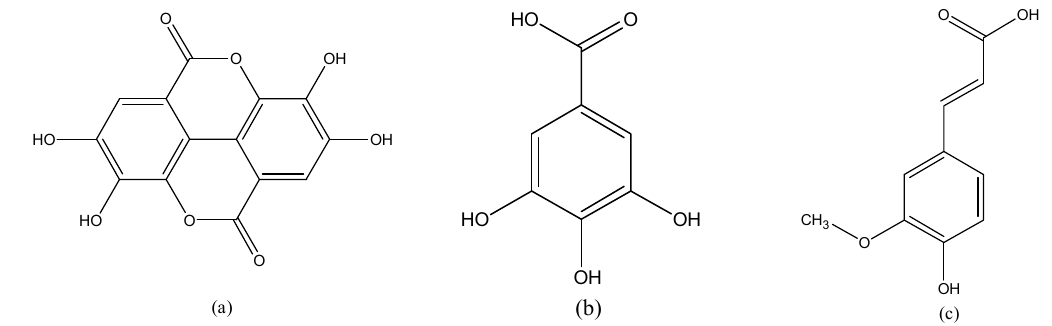
Figure 8. The chemical structures of ( a ) ellagic acid; ( b ) gallic acid and ( c ) ferulic acid.